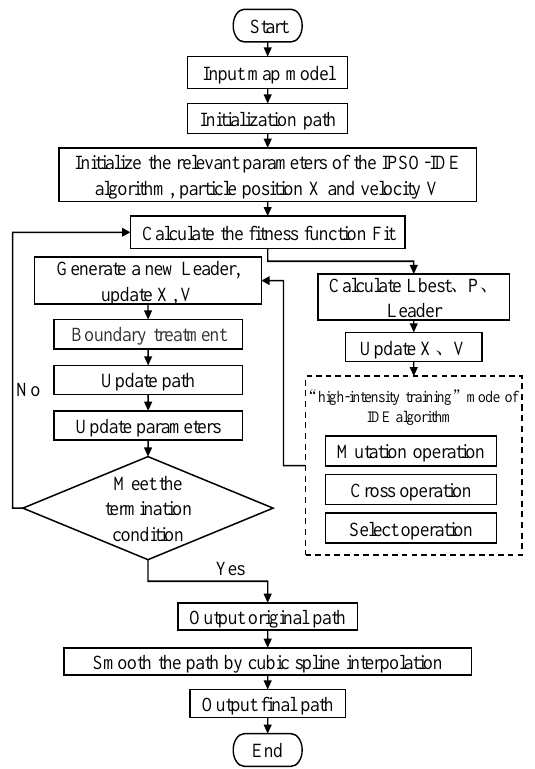
Figure 6. Flowchart of robot path planning based on the proposed algorithm.